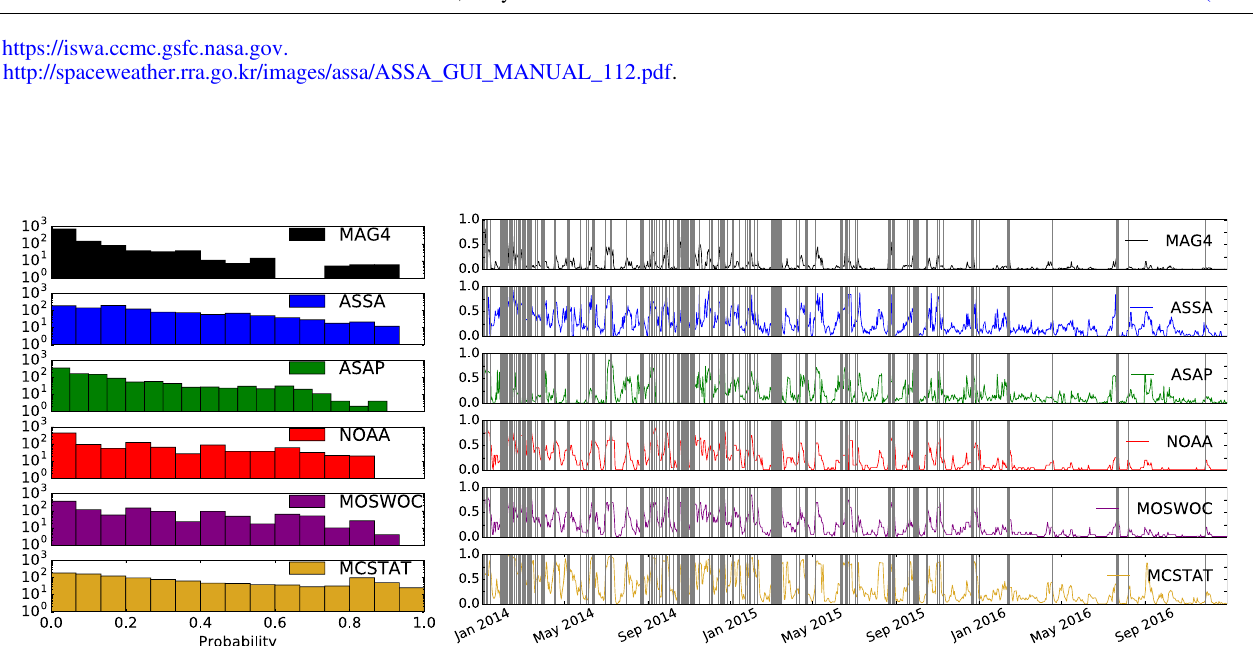
Table look-up + persistence + climatology; human corrected